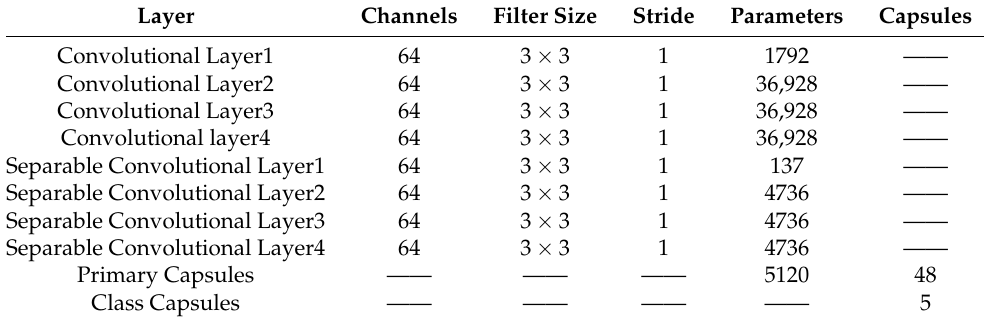
Figure 2. Proposed multi-input dual-stream capsule network, Φ o : Input images without pre- processing, Φ p : Input with pre-processed images. CLB: Convolutional Layers Block, SCLB: Separable Convolutional Layers Block. Table 1. Summary of the proposed